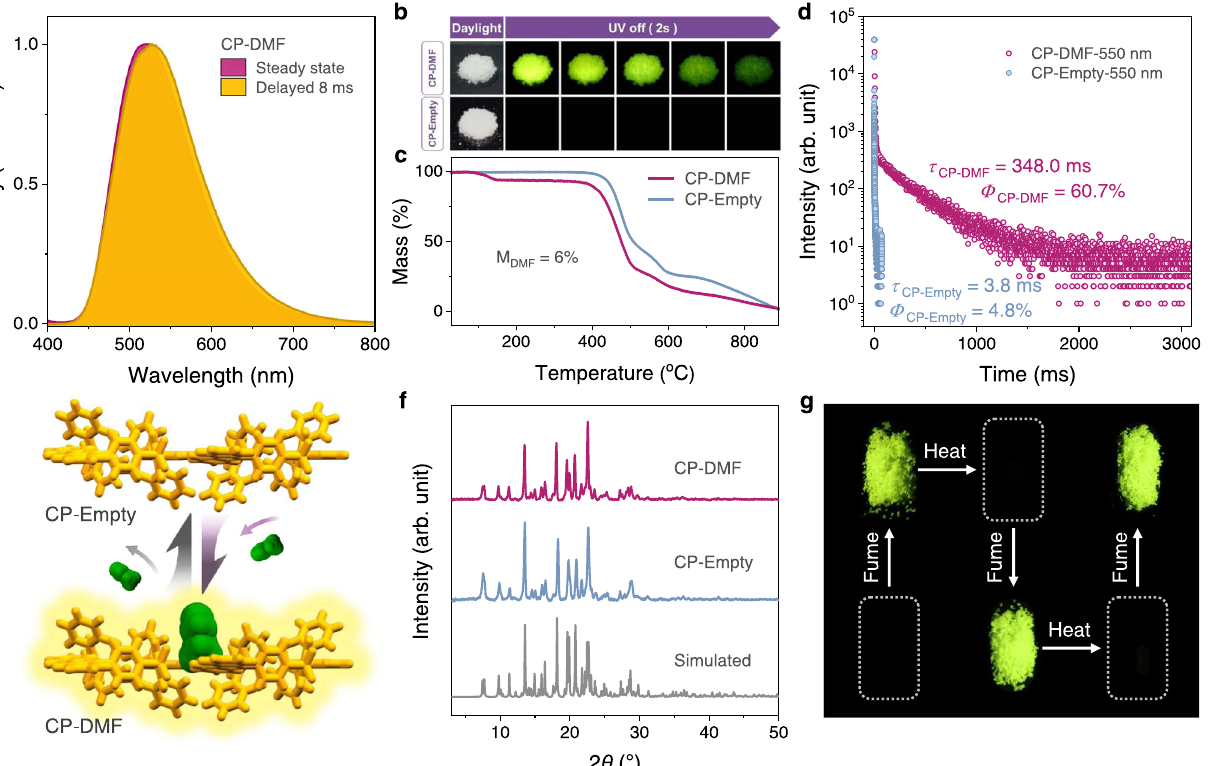
Fig. 3 | Dynamic URTP feature characterization of CP-DMF. a Steady photo- luminescence and phosphorescence spectra of CP-DMF crystals at room tem- perature under ambient conditions excited by 365nm. b Photographs of CP-DMF and CP-Empty crystals taken in daylight and after turning off the UV-light source under ambient conditions. c TGA curves of CP-DMF and CP-Empty crystals. d Lifetime decay pro fi les of CP-DMF and CP-Empty crystals measured at 550nm wavelength with a 355nm spectral-LED source under ambient